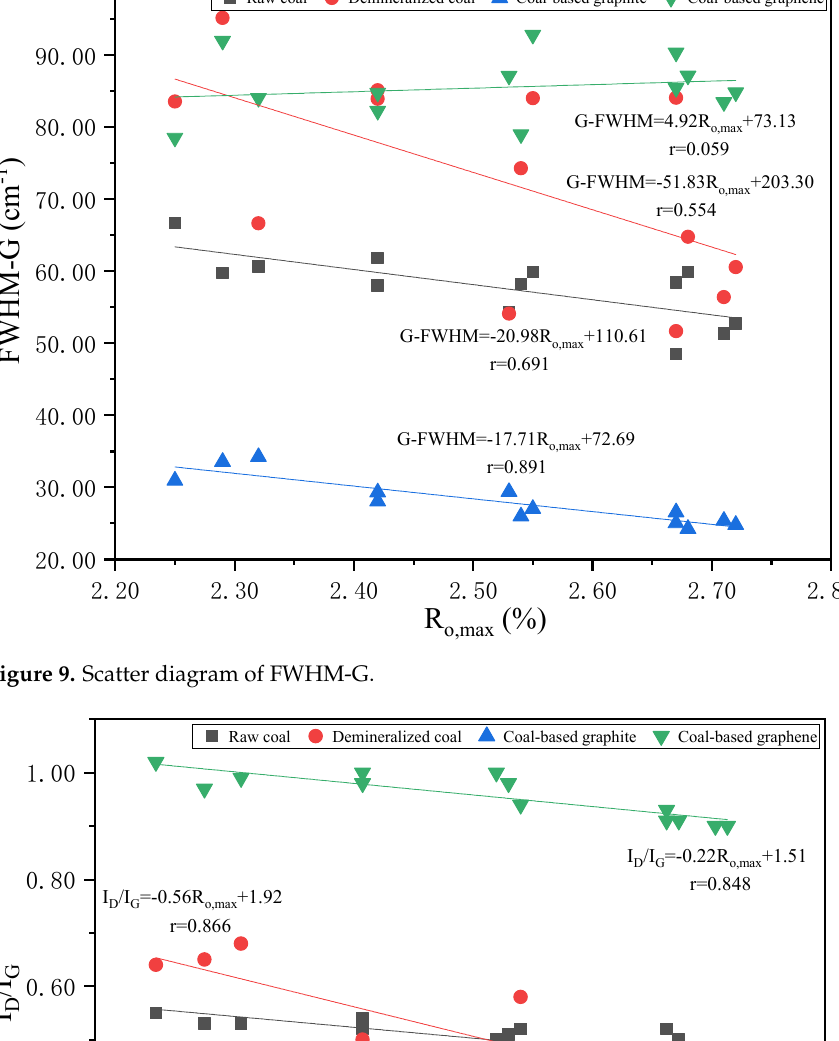
Figure 10. Scatter diagram of I D /I G . The D band of coal-based graphite shifted at ~1350 cm − 1 , the G band became sharper and shifted to ~1585 cm − 1 (Figure 11 and Table 7). A strong 2D peak appeared at ~2700 cm − 1 , which was sensitive to the stacking order of the graphene-like sheets along the c-axis [85], indicating the structure in the coal transformed well into a graphite